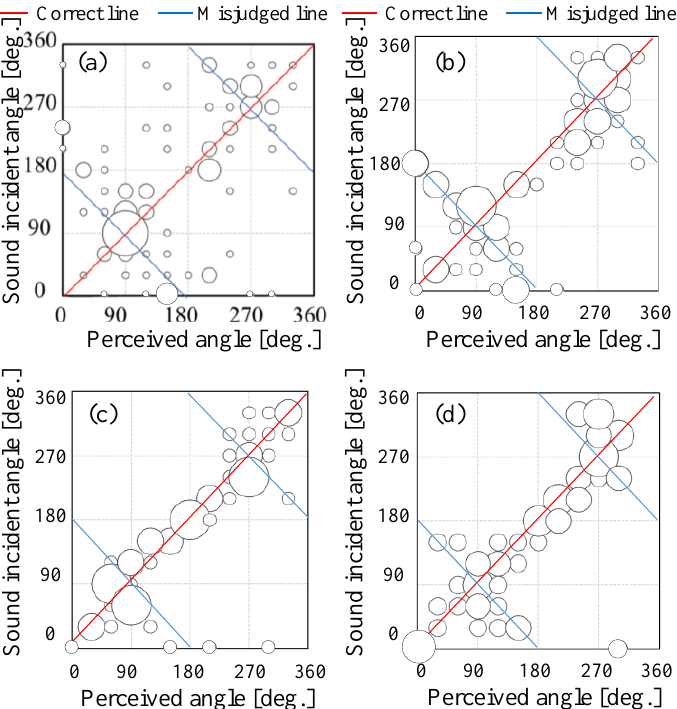
◦ , ( b ) θ = 10 ◦ , ( c ) θ = 20 ◦ , and ( d ) θ = 30 ◦